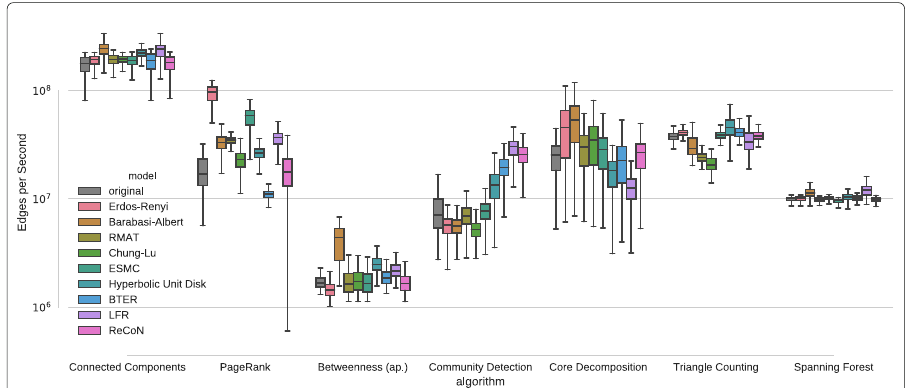
Fig. 5 Running time replication of a set of network analysis algorithms. Running times are in edges per second, i.e., higher is